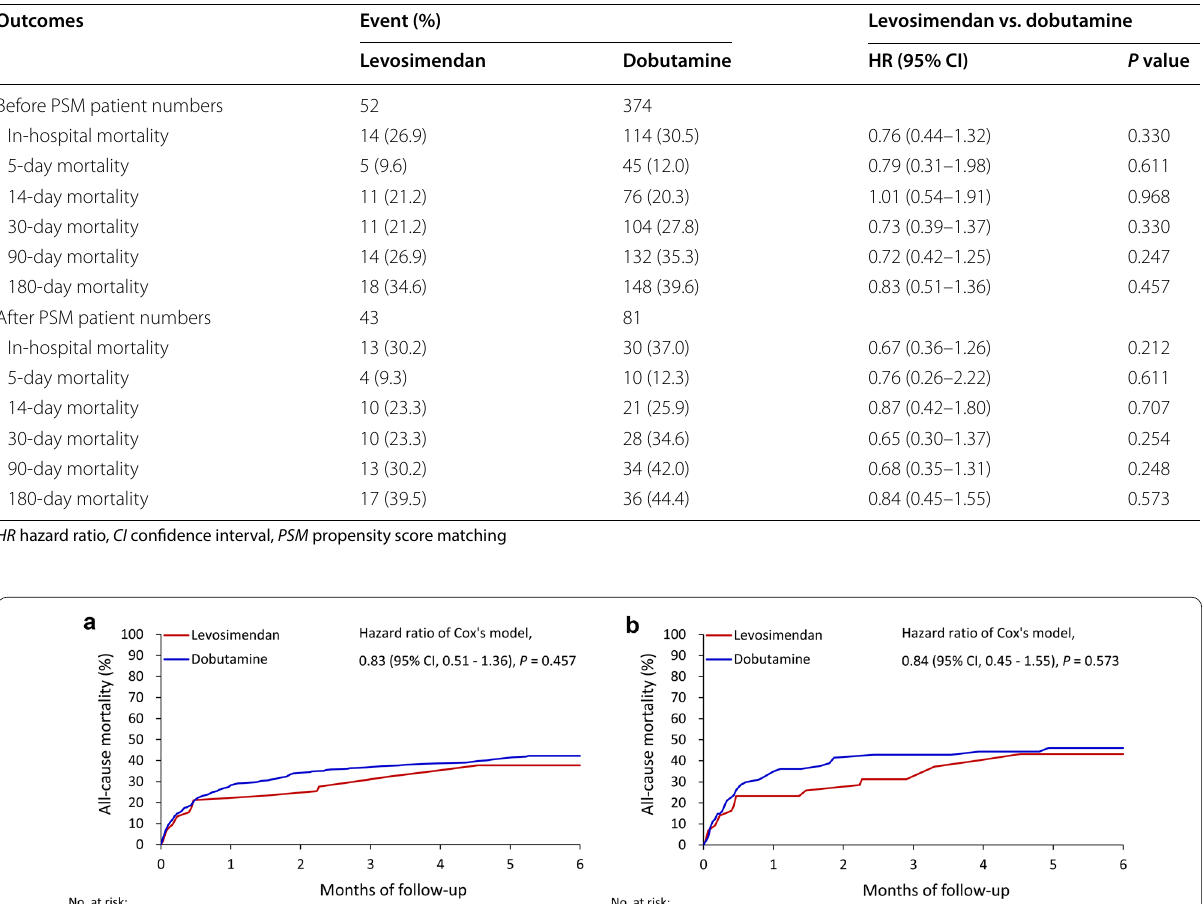
Table 4 Mortality rates of patients with eGFR < 30 or dialysis who received levosimendan versus dobutamine alone